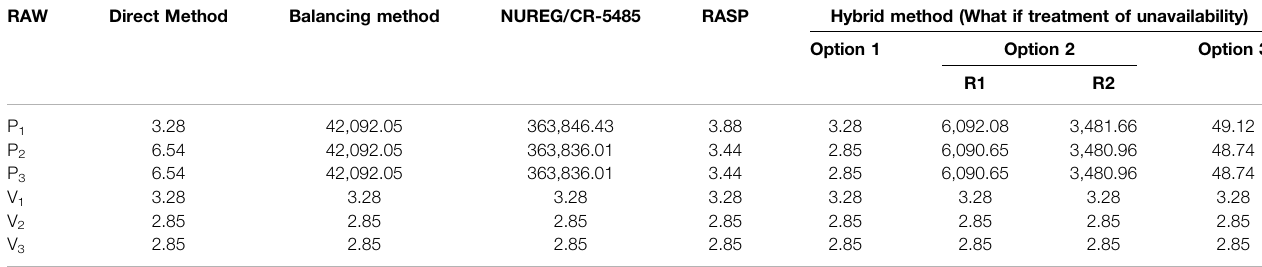
TABLE 3A | RAW importance results of different methods (t (cid:2) 120 h). RAW Direct Method